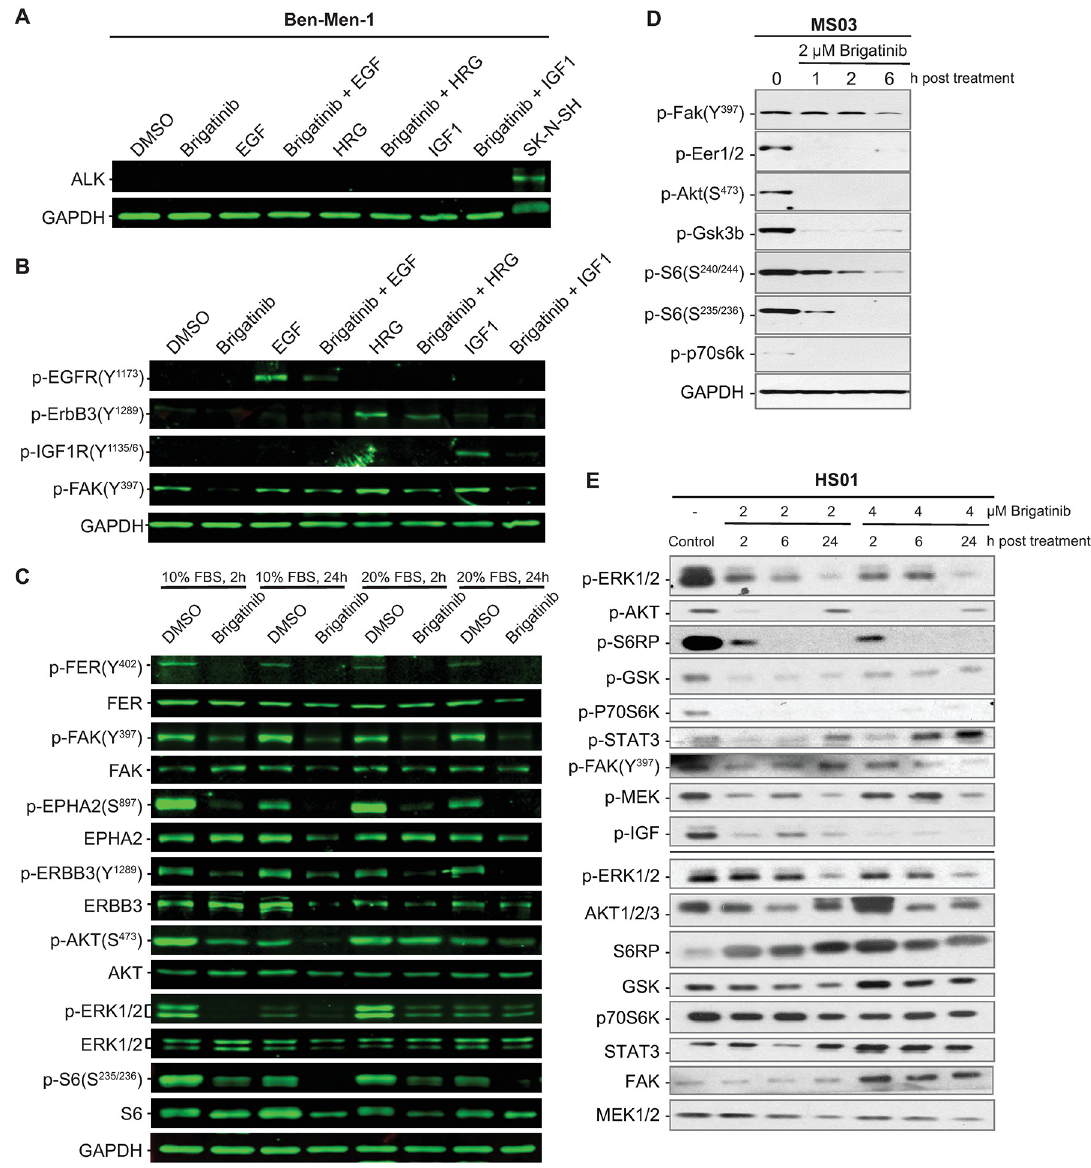
Fig 4. Brigatinib inhibits multiple RTKs, non-RTKs, and their downstream signals. (A) Western blot analysis was conducted to detect ALK expression in Ben-Men-1 cells grown under various growth conditions and with or without brigatinib treatment. (B) Brigatinib treatment greatly reduced phosphorylation of non-RTKs FER and FAK, RTKs EPHA2 and ErbB3, and their downstream signaling molecules AKT, ERK1/2, and S6 in active growing Ben-Men-1 cells or growth-arrested cells stimulated with 20% serum. (C) Brigatinib blocked phosphorylation of EGFR, ErbB3, and IGF1R in growth-arrested Ben-Men-1 cells stimulated with each cognate ligand. (D) Brigatinib reduced the levels of p-FAK, p-ERK1/2, p-AKT, p-S6, and p-Gsk in Nf2 deficient murine Schwann Cells. (E) Brigatinib reduced phosphorylation of FAK, ERK1/2, MEK, AKT, S6RP, p70S6K, STAT3, and IGR in NF2 -deficient HS01 human Schwann cells. increased concentrations of brigatinib in the serum but not in the CNS compared with treat- ment of brigatinib alone (Figs 5A and S11). As measured by luminescence engineered into the meningioma cells, brigatinib, both alone and in combination with MK-2206 blocked out- growth of the xenograft (Figs 5B, 5C and S12).